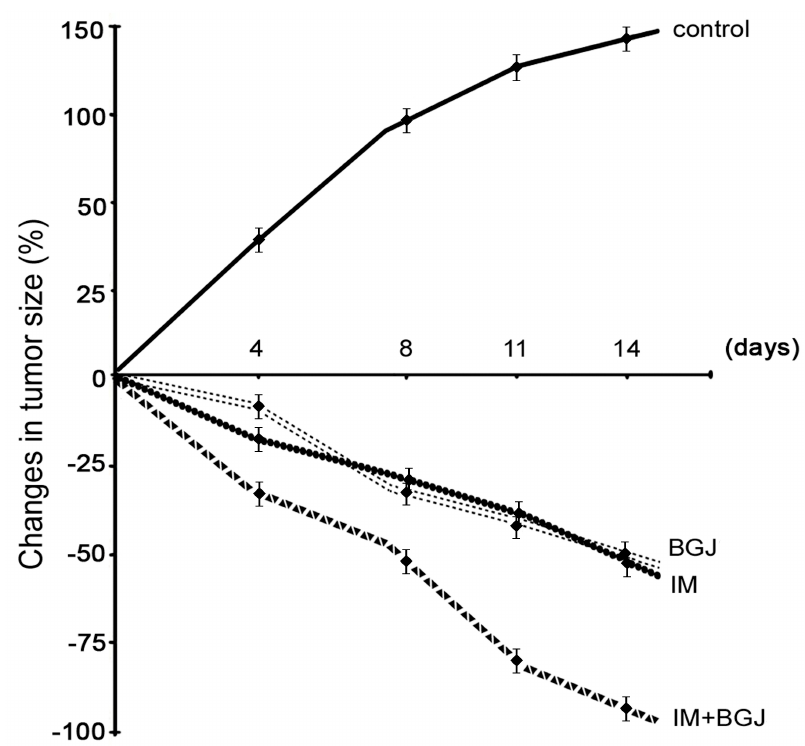
Figure 4. Dynamics of the tumor volume of GIST T-1R xenografts. Nude mice bearing GIST T-1R xenografts were orally administered daily with 50 µ L of either a vehicle (negative control), IM (50 mg/kg), BGJ398 (20 mg/kg), or a combination of the drugs indicated above. The changes in tumor size were calculated as a percentage of the